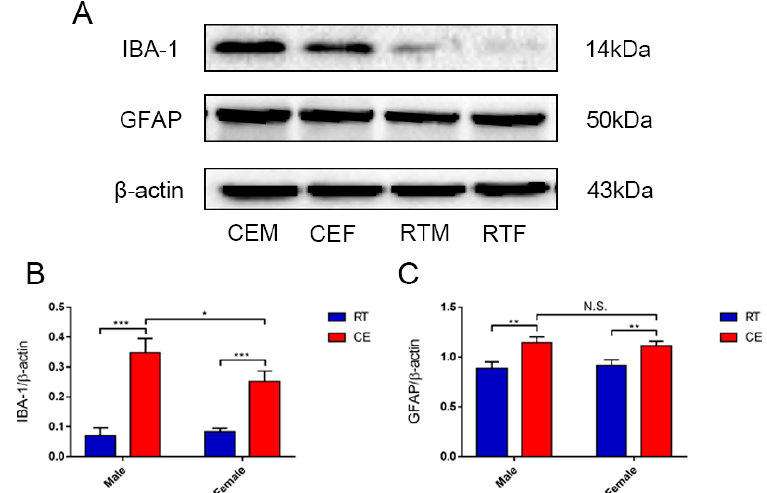
Figure 2. Expression of glial cell makers in hippocampal tissue lysates of cold-stressed mice, as determined by western blotting and densitometric analysis. ( A ) IBA-1, glial fibrillary acidic protein (GFAP), and β -actin levels in each group. ( B , C ) Quantification of expression levels based on expression ratios of IBA-1 / β -actin ( B ) and GFAP / β -actin ( C ). Di ff erences between room temperature male (RTM) and cold exposure male (CEM), room temperature female (RTF) and cold exposure female (CEF), and CEM and CEF groups were evaluated by two-way analysis of variance. Results are expressed as the mean ± SD ( n = 6) of four independent experiments. N.S.: not significant; * p < 0.05, ** p < 0.01, *** p <